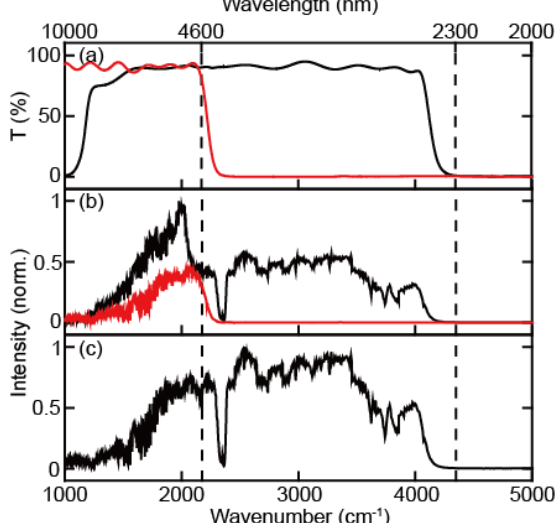
Figure 3. ( a ) Transmittance spectrum of 2.4 µ m IR long-pass filter (black) and 4.5 µ m IR long-pass filter (red). ( b ) Continuum IR spectra obtained with 2.4 µ m IR long-pass filter (black) and 4.5 µ m IR long-pass filter (red). ( c ) Corrected continuum IR pulse spectrum, where the spectrum under and over 4.5 µ m are obtained with 4.5 µ m and 2.4 IR long-pass filter, respectively.